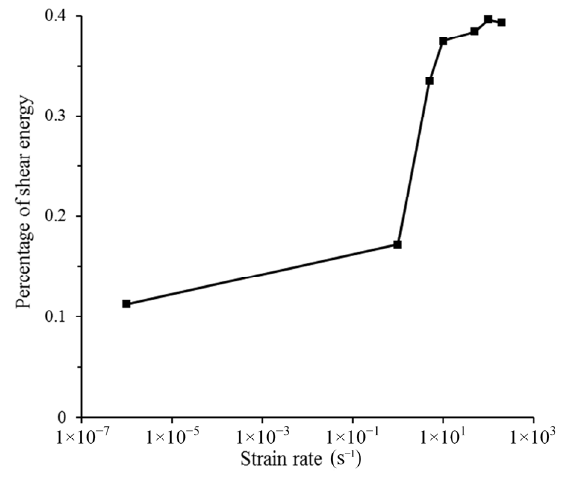
Figure 13. The percentage of shear energy in all dissipated energy.